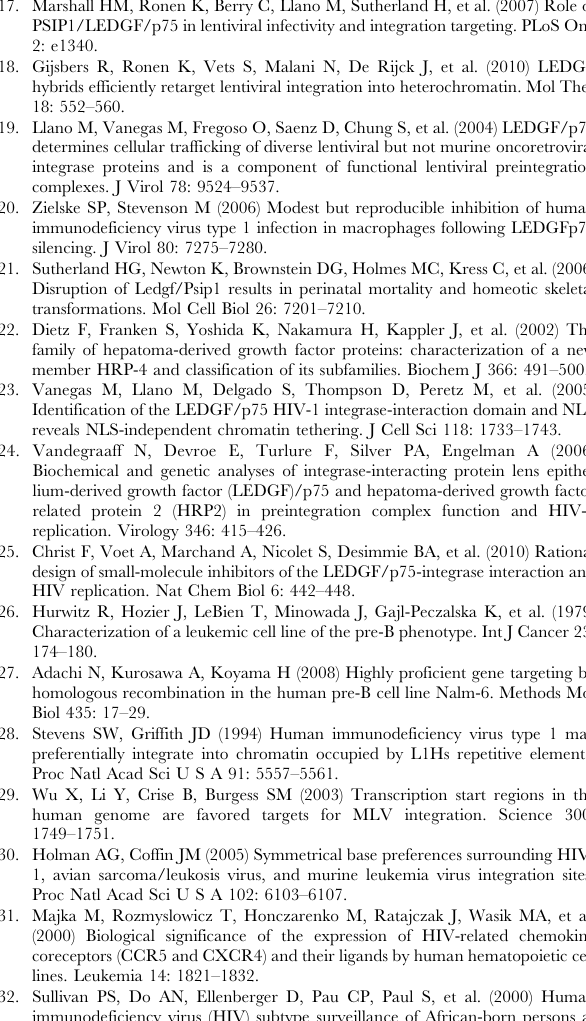
Figure S7 Schematic overview of viral vector constructs. (A) Lentiviral vector construct for CD4 expression. (B–D) Different lentiviral vectors to generate stable HRP-2 KD and control cell lines, ordered pairwise, are shown. Abbreviations: IRES, internal ribosomal entry site; Hygro, hygromycin B; HRP-2, Hepatoma derived growth factor related protein 2; Bsd, blasticidin; Zeo, zeocin. Table S1 IC 50 values for LEDGINs (LEDGIN 7) and INSTIs (RAL). IC 50 values for LEDGIN 7 and Raltegravir were calculated based on data shown in figure 6. Data were fitted to a sigmoidal dose-response (variable slope) curve, from which IC 50 values were calculated. Mean and 95% confidence interval are shown. Table S2 Overview of primers and probes used. Primers and probes used throughout the manuscript are shown.